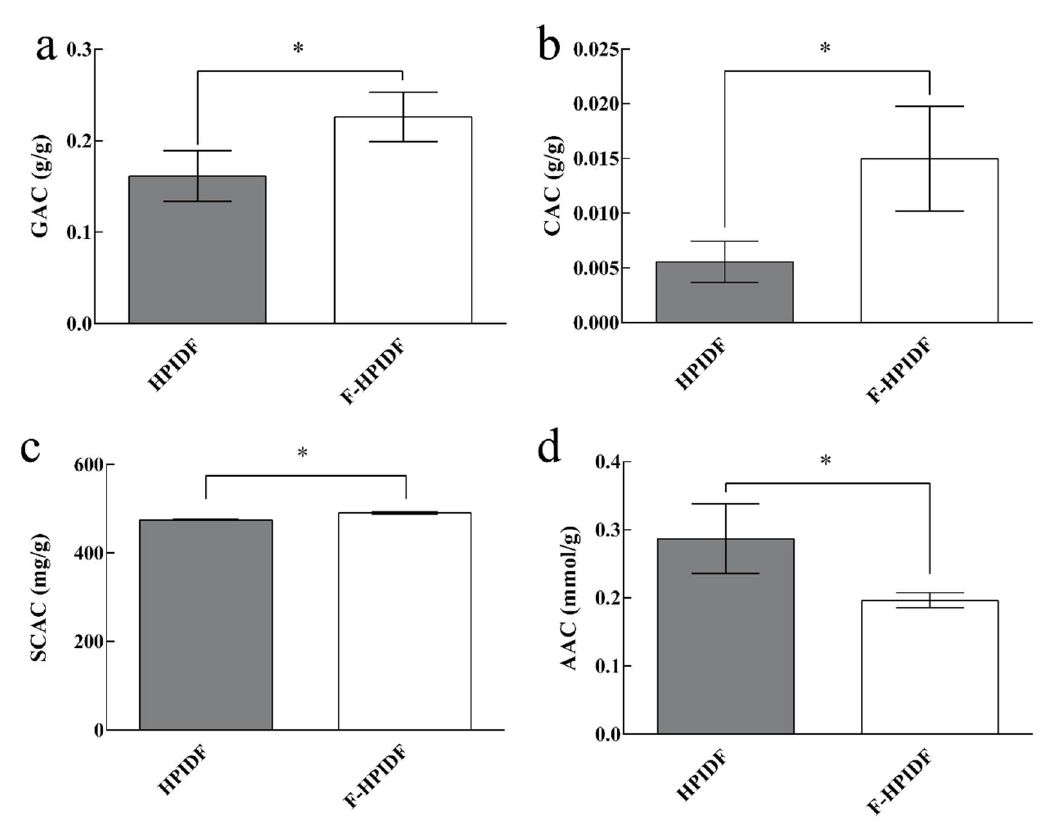
Figure 8. Potentially harmful substances-adsorption capacity of HPIDF/F-HPIDF. ( a : GAC; b : CAC; c : SCAC; d : AAC; *: p <